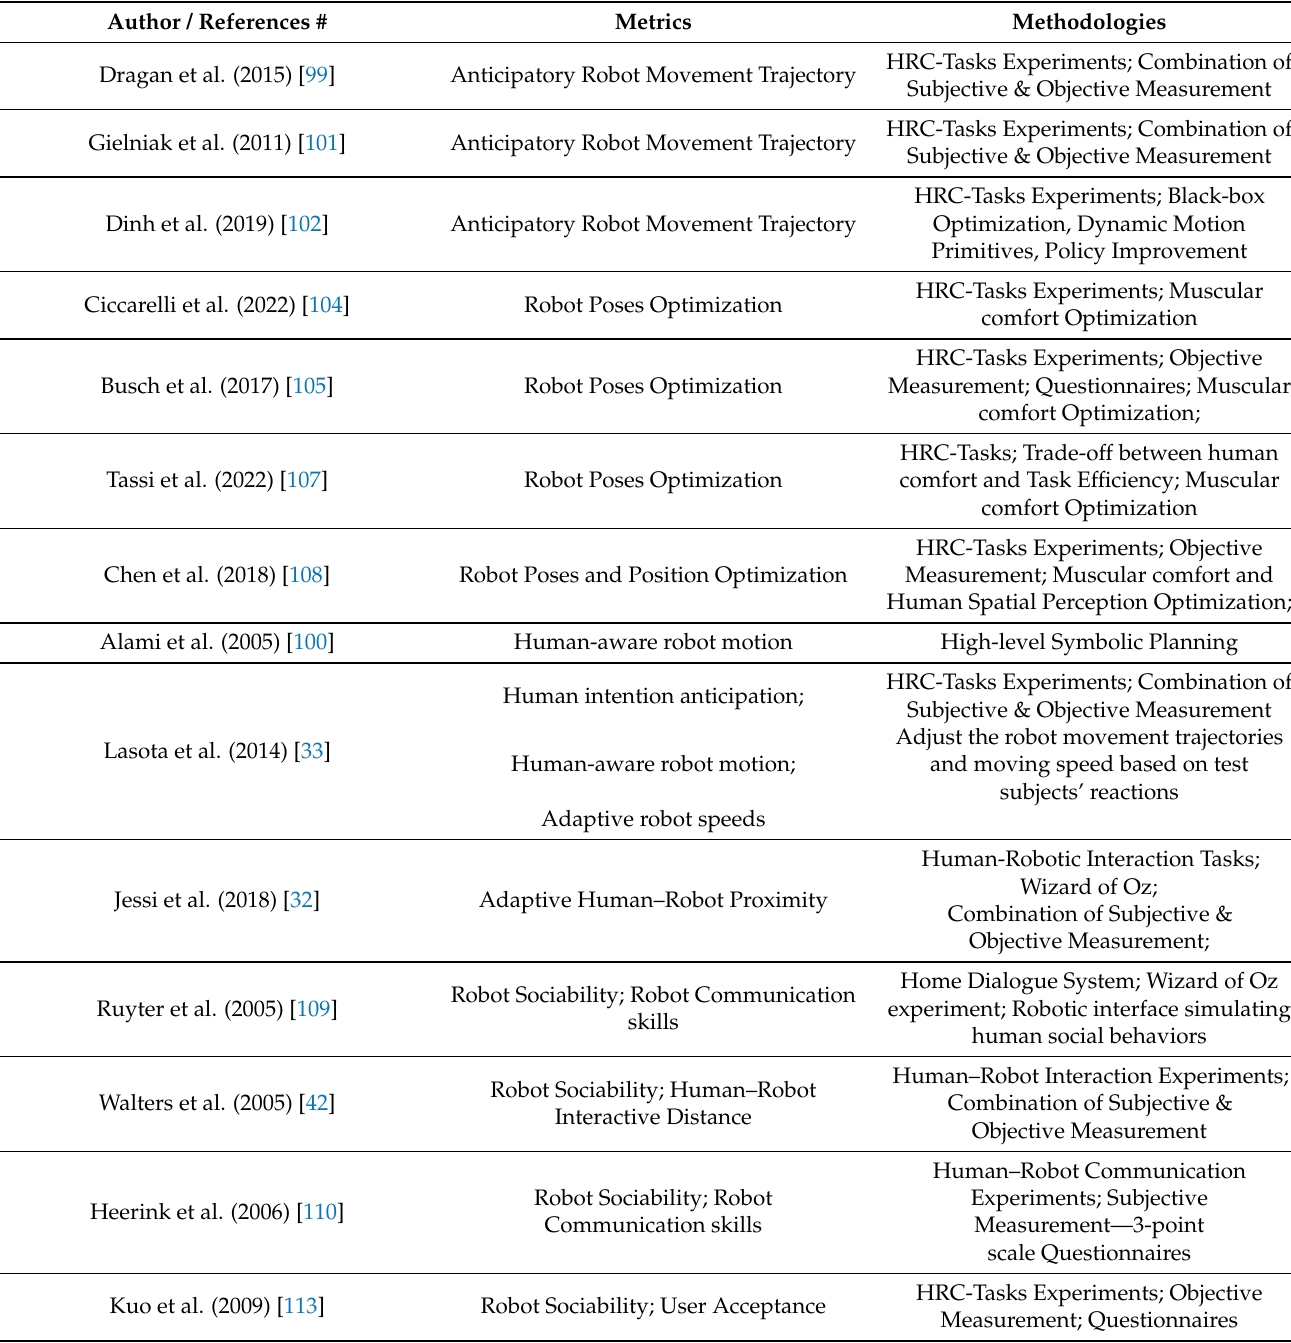
Table 3. Comfort improvement